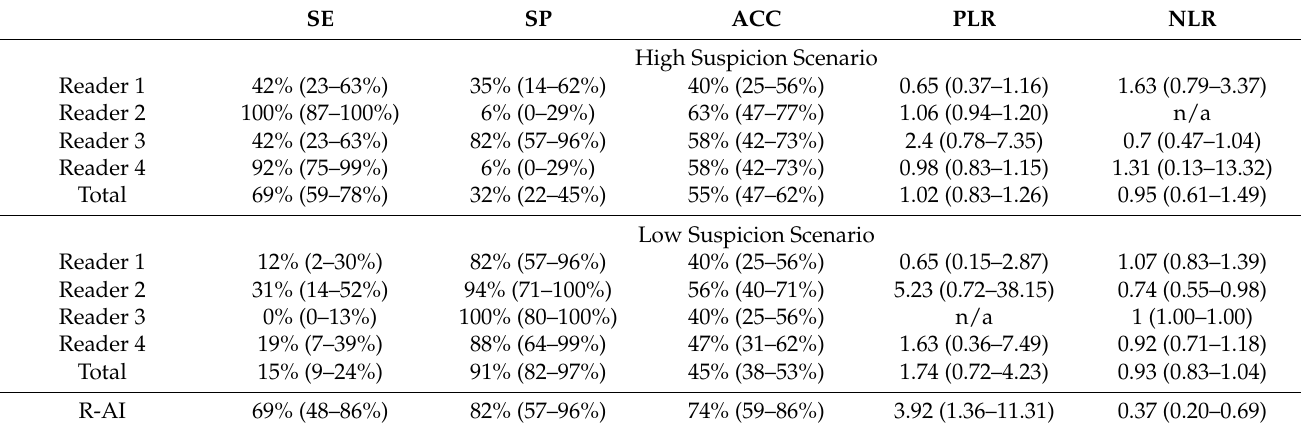
Table 5. Diagnostic performance of radiomic-based artificial intelligence classifier (R-AI) and human readers in classifying the subset ( n = 43) of patients who were assigned a CO-RADS 3 score by two or more